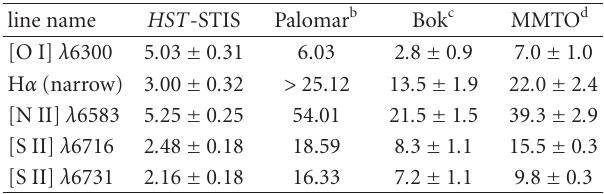
Table 2: Emission line measurements a